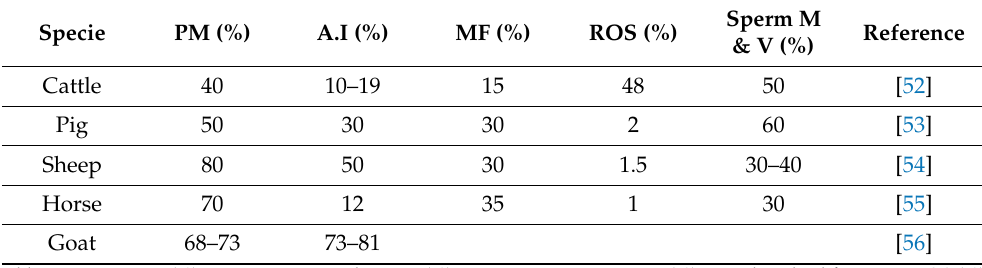
Table 1. Sperm cryopreservation variations specific to